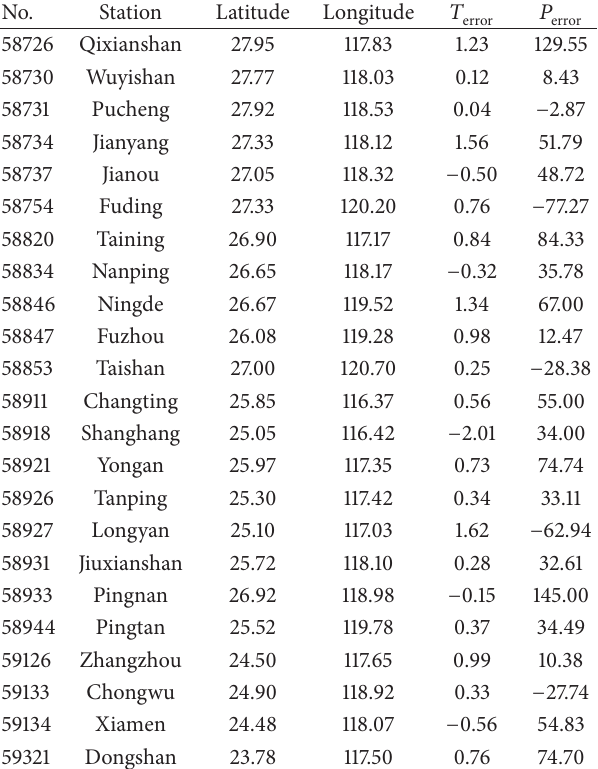
Table 1: Comparison of the meteorological station observed (OBS) and model simulated annual near-surface temperature at 2 meters height (unit: ∘ C) and precipitation error (unit: mm) over 23 weather stations in Fujian province in